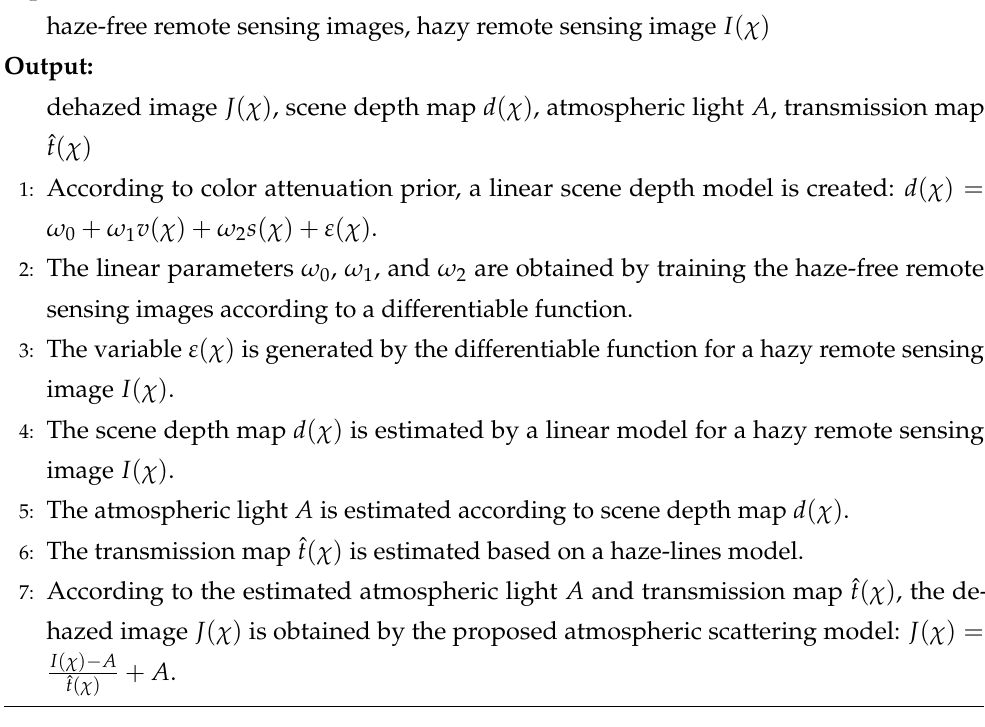
Algorithm 1 The Proposed Dehazing Algorithm for Remote Sensing